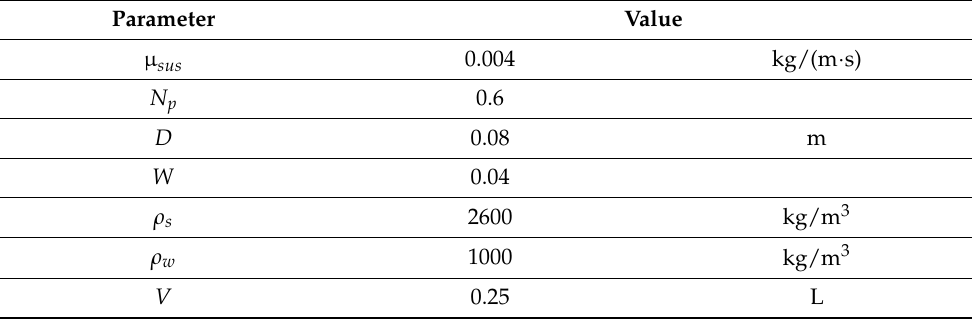
Table 1. Inputs to calculate the mean shear rate.